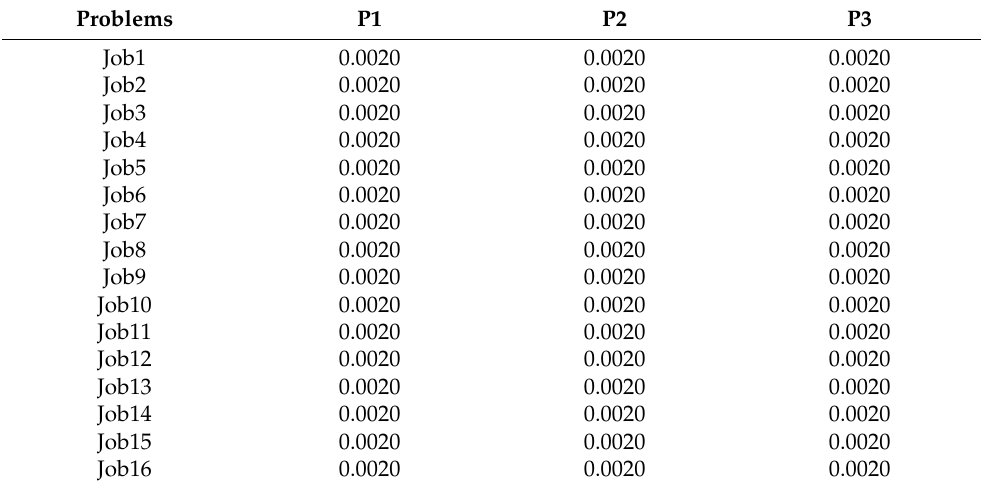
Table 11. The p -value of the Wilcoxon signed-rank test of the HV -metric between two algorithms.